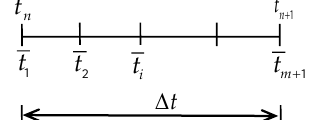
Figure 1. A time element of degree m.